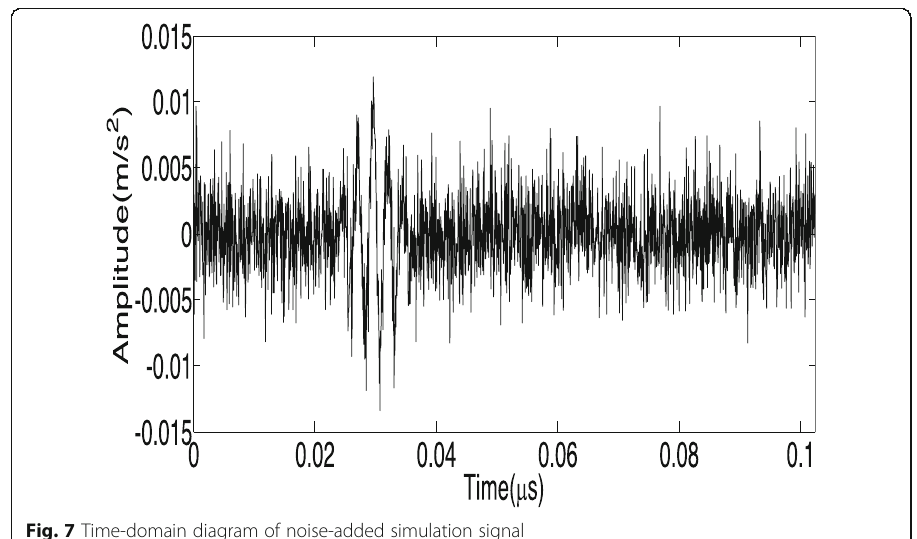
Fig. 7 Time-domain diagram of noise-added simulation